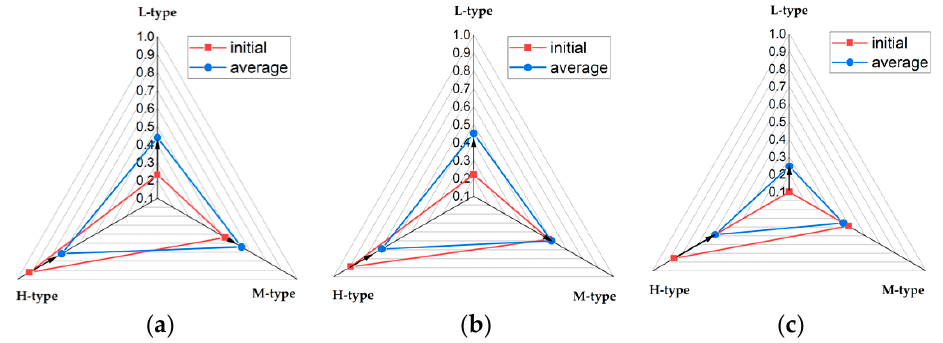
Figure 7. Individuals’ risk preference in different contexts: ( a ) Low risk context; ( b ) Medium risk context; ( c ) High risk context (L-type: agents with low initial risk preference, M-type: agents with medium initial risk preference, H-type: agents with high initial risk preference).